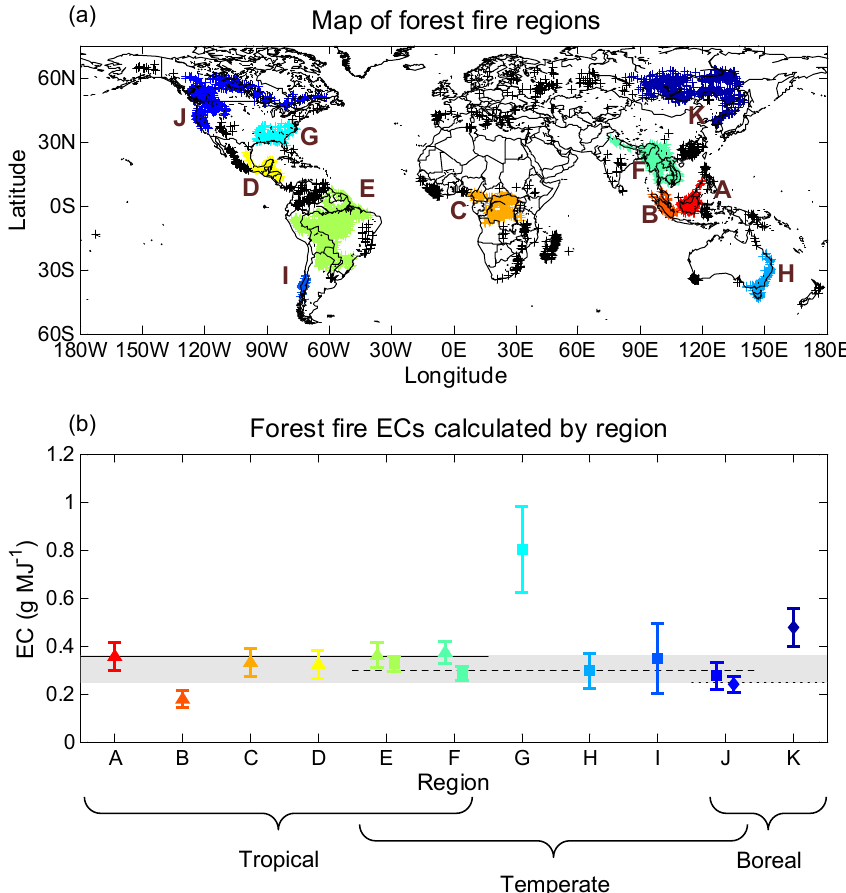
Fig. 3. A map of forest fire regions determined by a clustering analysis (a) and ECs calculated individually for each region (b) . In (a) , black markers identify forest fires belonging to clusters with less than 100 observations. In (b) , marker shapes are used to identify biomes for each EC, determined via climate classifications: triangles indicate tropical, squares indicate temperate, and diamonds indicate boreal forests. In regions where there is adequate sampling of more than one biome type, ECs are calculated for both biomes (e.g. Region E). The tropical (solid), temperate (dashed) and boreal (dotted) forest mean biome ECs are indicated by the black horizontal lines. The range of all mean biome ECs (as presented in Table 2) is indicated in